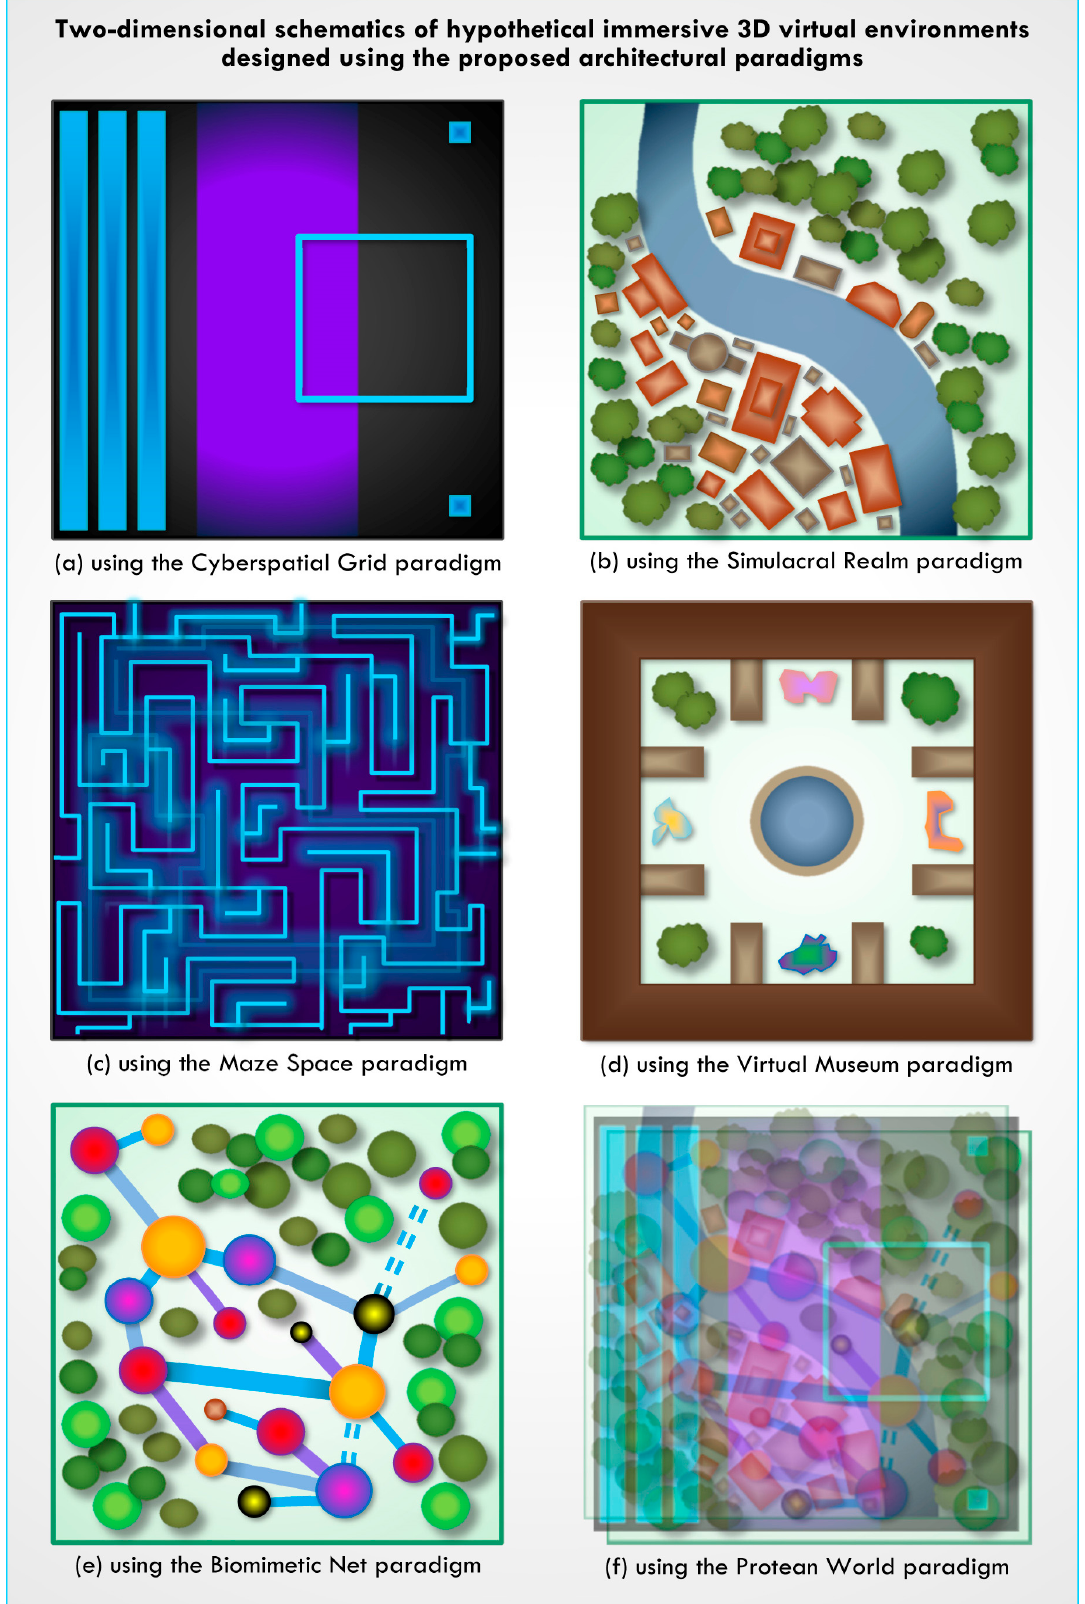
Figure 4. This study has proposed a framework of six architectural paradigms for use in the user-centered design of virtual environments.